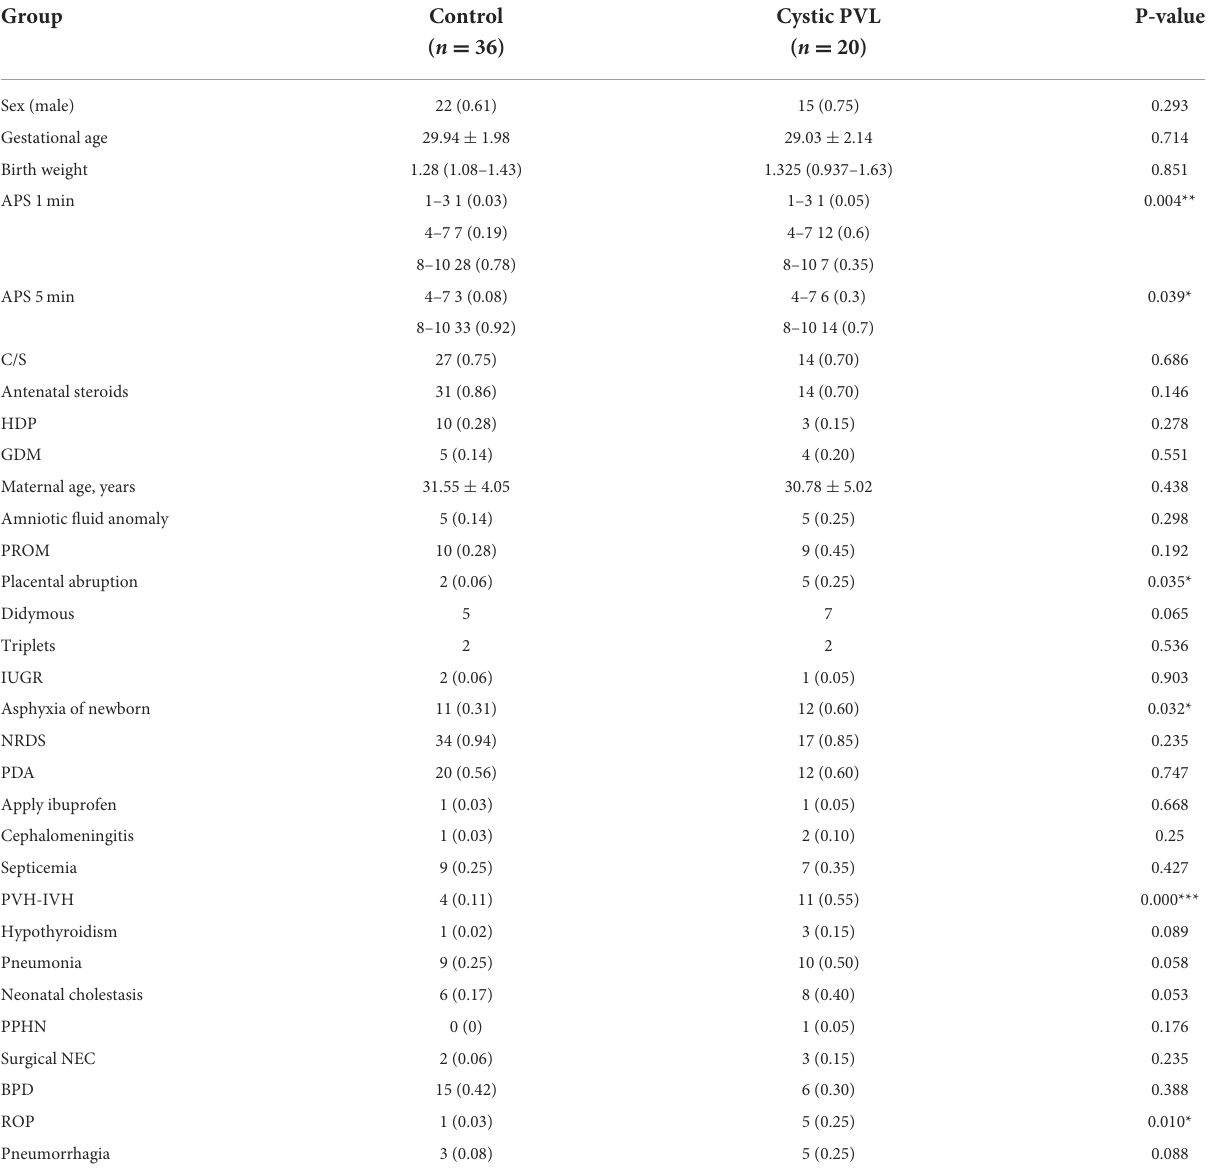
TABLE 1 Comparison of general conditions and risk factors in the study population. Group